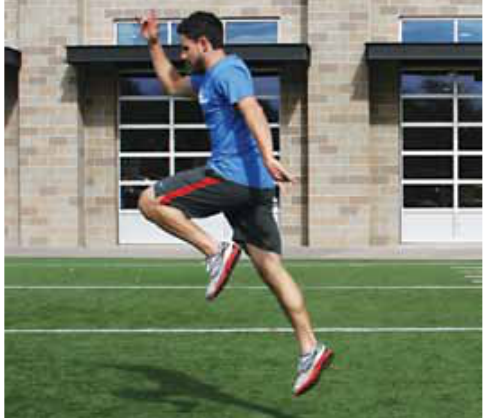
Figure 5-17. Power Skips for